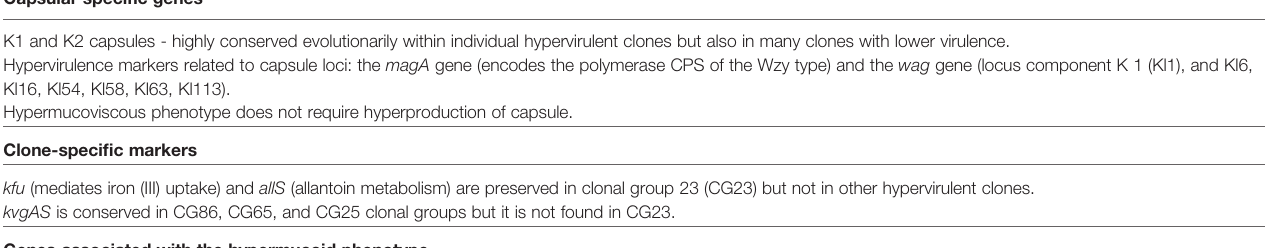
TABLE 2 | Putative determinants of hypervirulence K. pneumoniae (hvKp) (Hsu et al., 2011; Holt et al., 2015; Wyres et al., 2016; Lam et al., 2018a; Lam et al., 2018b; Russo et al., 2018; Walker et al., 2019; Wyres et al., 2019). Capsular speci fi c